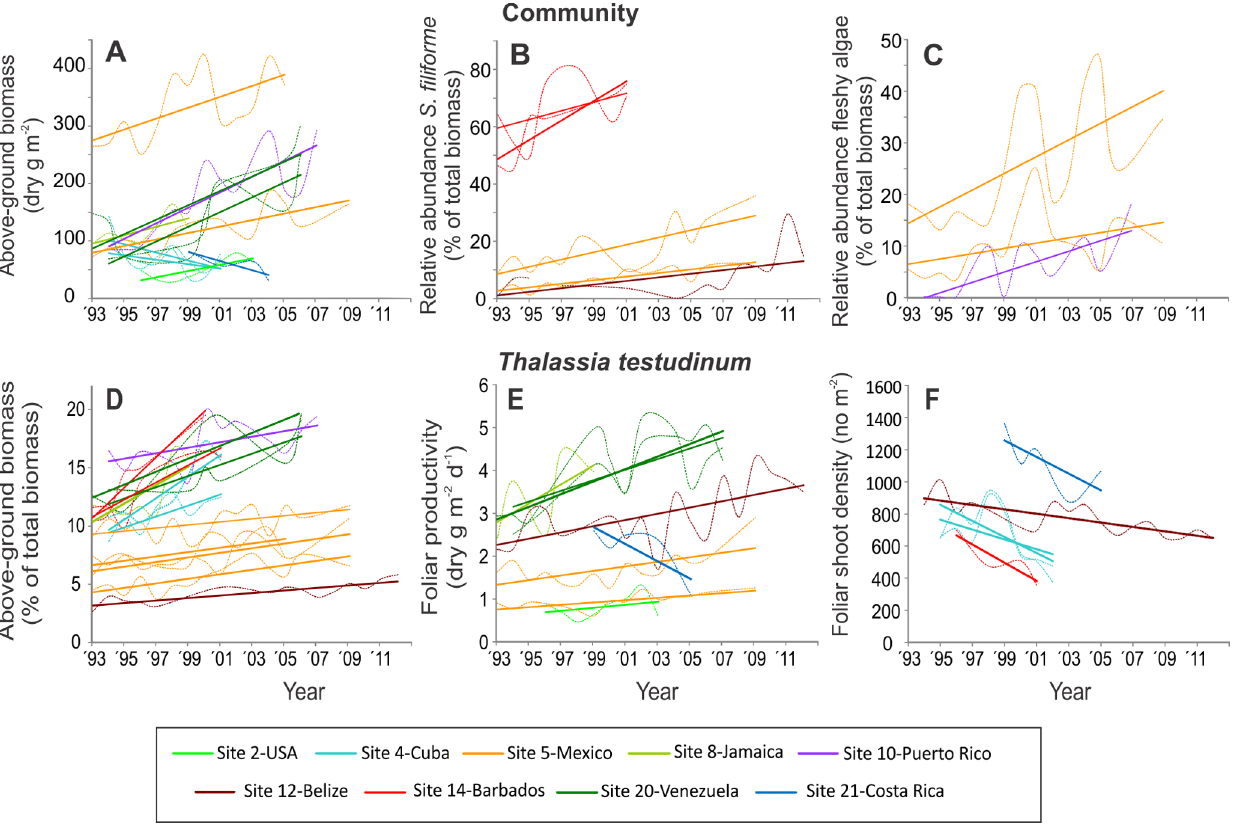
Figure 5. Significant long-term trends in seagrass attributes and community parameters at CARICOMP monitoring stations across the nine sites that showed changes consistent with deterioration of the environmental conditions. The broken smoothed lines connect annual average values and serve to illustrate the inter-annual variability in the data. Data from all samples per year (N=4-9, Table S3) were used to determine the regression lines (Table S6). D. For Site14, the relationship was determined for the more persistent Syringodium filiforme .